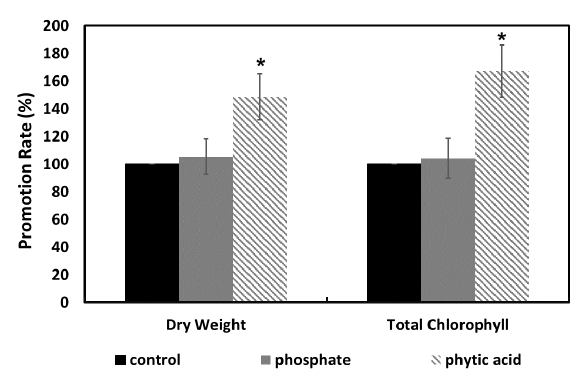
Figure 4: Comparison of phytic acid and phosphate for their effect on the dry weight and total chlorophyll content of E. gracilis . Concentration of phytic acid and phosphate was 1.085 mM and 6.51 mM, respectively (phosphorus content was 6.51 mM). Asterisks indicate the significant difference ( p < 0.05) between experimental and control